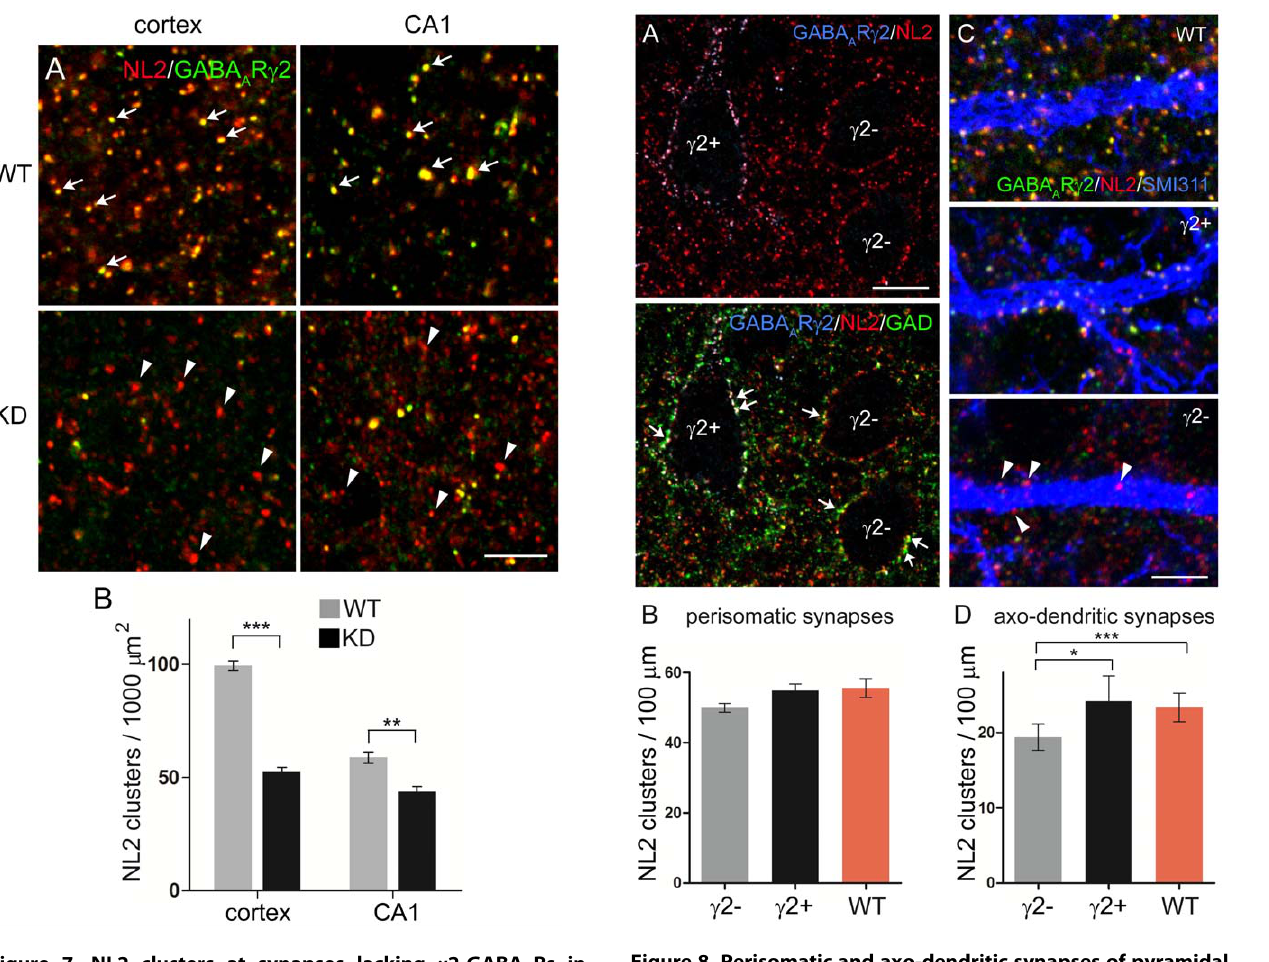
Figure 7. NL2 clusters at synapses lacking c 2-GABA A Rs in cortical and hippocampal circuits. A, Confocal images of sensorimotor cortex (layer V) and hippocampal CA1 ( stratum radiatum ) after double labeling for NL2 (red) and GABA A R c 2 (green). Note that in WT NL2 puncta co-localize extensively with c 2-positive structures (arrows). In contrast, in c 2 KD mice many puncta are labeled for NL2 but not for the c 2 subunit (triangles). B, Reduced density of NL2-positive clusters in cortical and hippocampal neuropil of c 2 KD mice as compared with WT (***, p , 0.0001,** p=0.0031; unpaired t -test; n=3 mice per group). Scale bar: 3 m m.